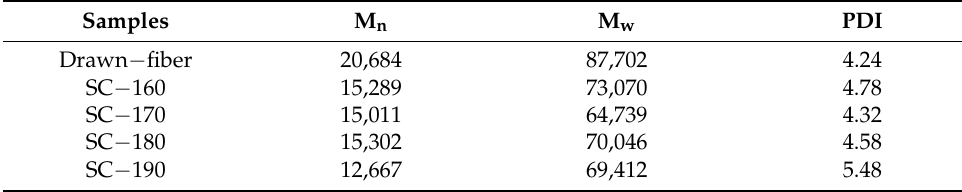
Table 4. Molecular weight and distribution of drawn − fiber and SC − PLA